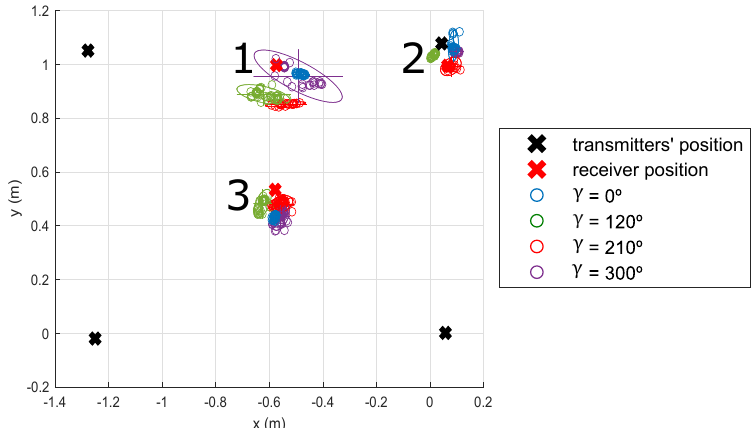
Figure 12. Experimental position estimates at z = 0m for γ = {0 ◦ , 120 ◦ , 210 ◦ and 300 ◦ } with the IPPE